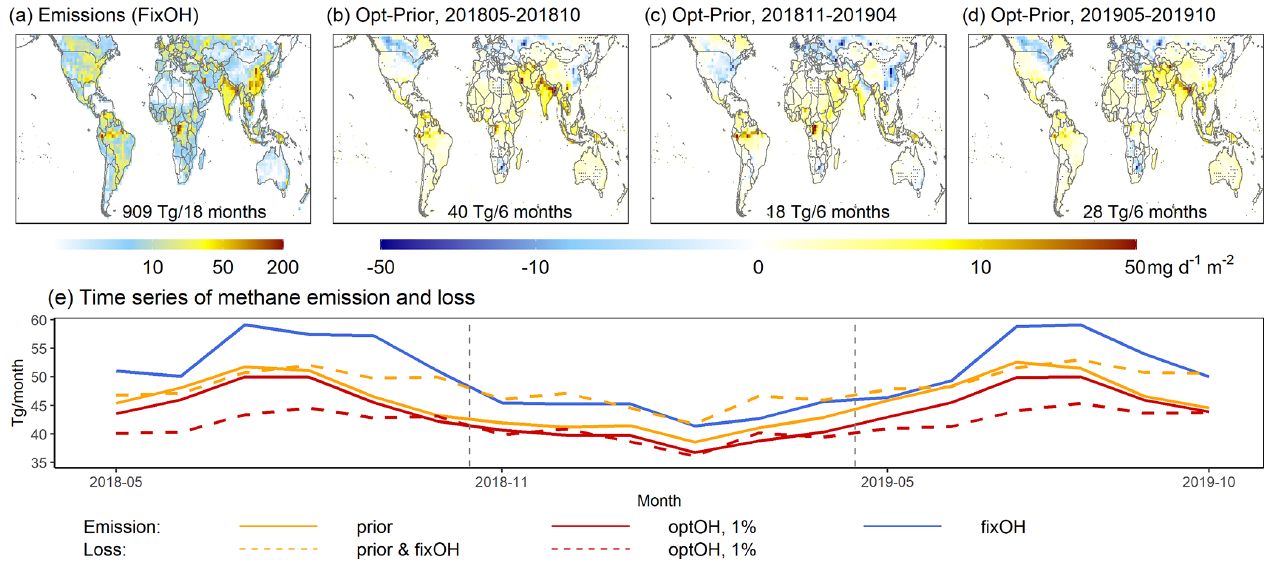
Figure 4. (a) Optimized global methane emissions based on the fixOH inversion ensemble. (b–d) Seasonal fixOH emission corrections. Dots indicate missing sources where the EE and BI inversions point to positive corrections that the SF inversion misses. (e) Time series of prior and optimized methane sources and